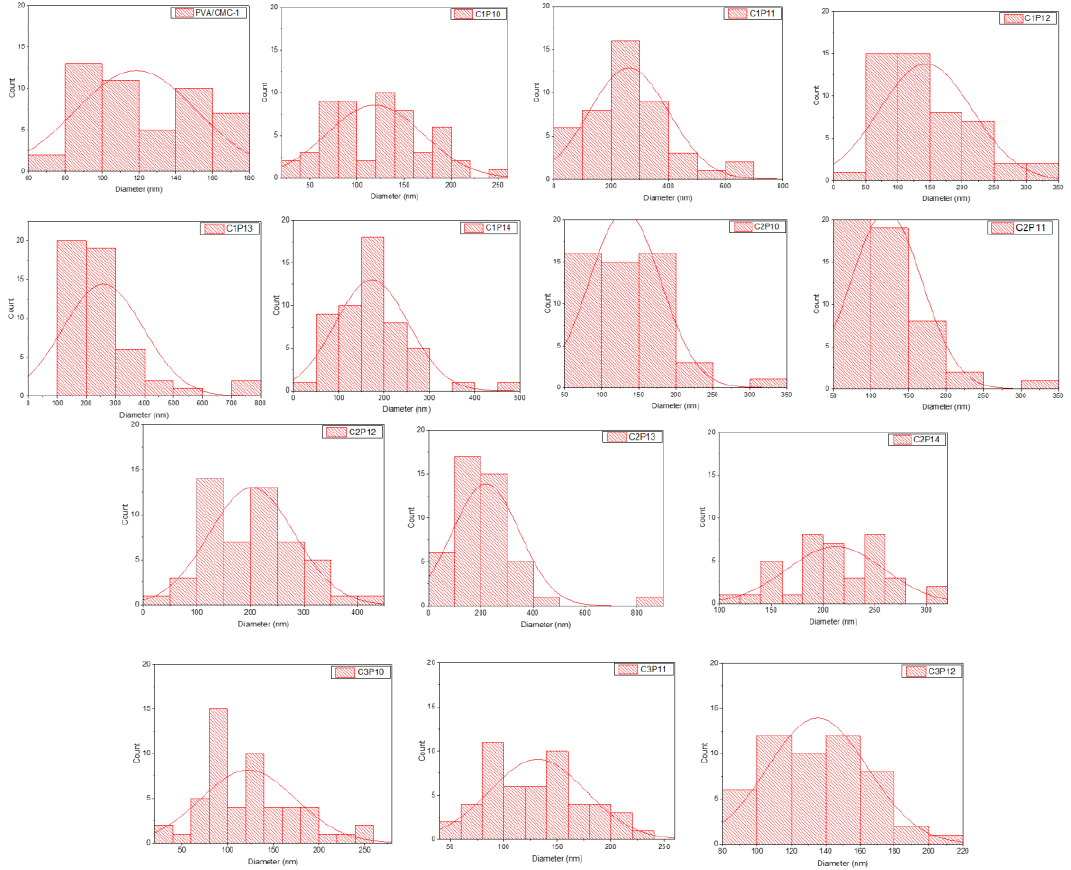
Figure 3. Diameter distribution plots (histogram) of PVA / CMC, PVA / PVP, and tri-component composite nanofibers of PVA, PVP, and CMC (C1P10–C3P12) .